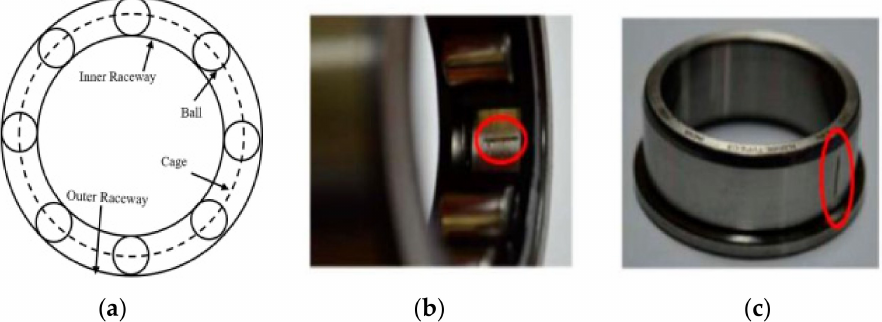
Figure 1. ( a ) Bearing geometry; ( b ) fault in the outer race; ( c ) fault in the inner